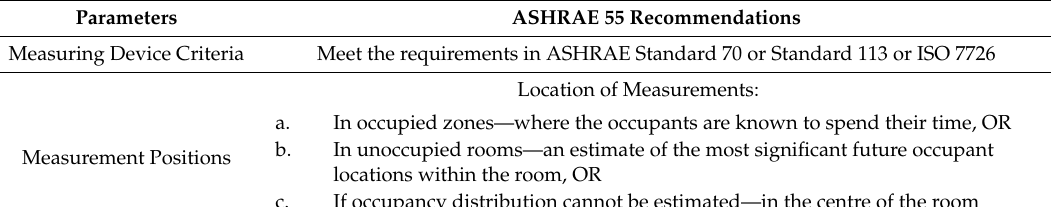
Table 3. Evaluation of thermal environment in accordance with ASHRAE 55 (Thermal Environmental Conditions for Human